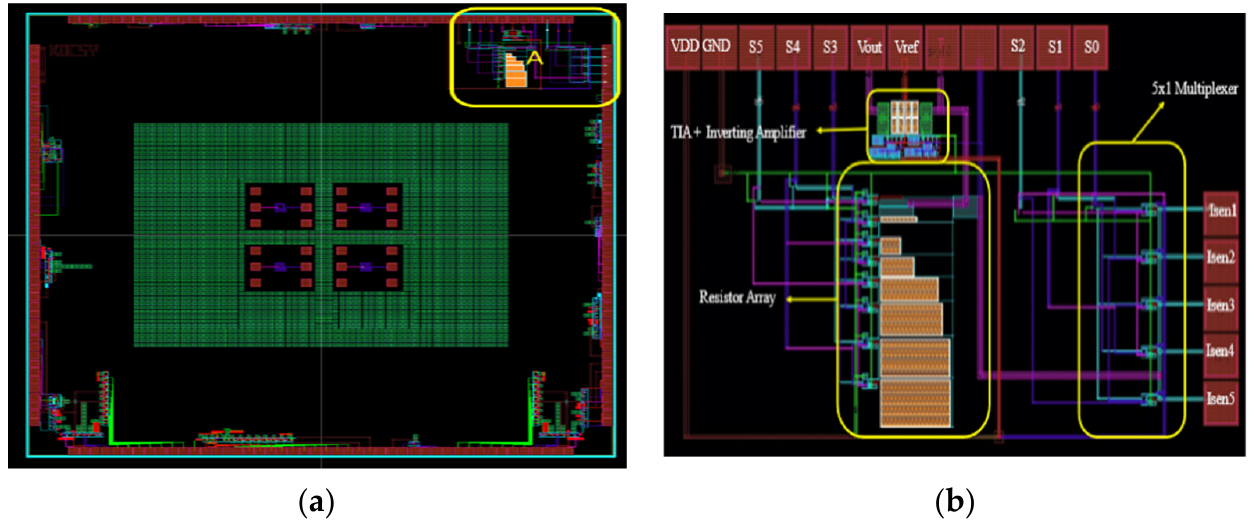
Figure 8. ( a ) Layout of the fabricated chip; ( b ) layout of the proposed readout circuit.